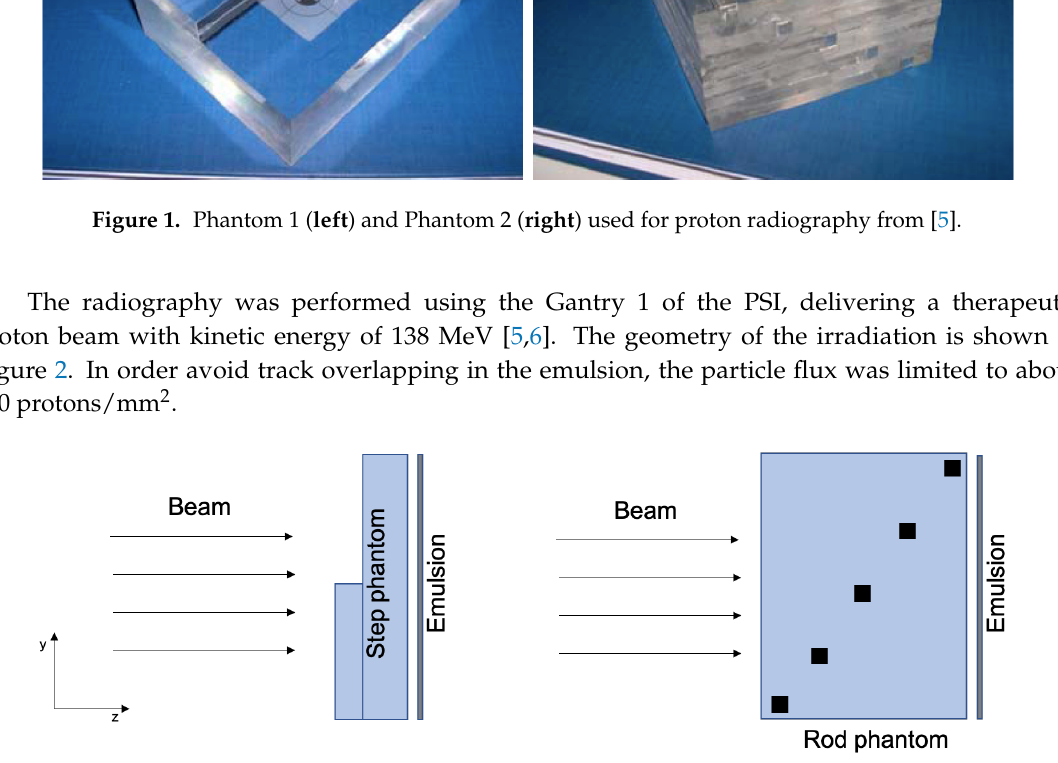
Figure 2. Scheme of the irradiation of the step ( left ) and rod ( right )